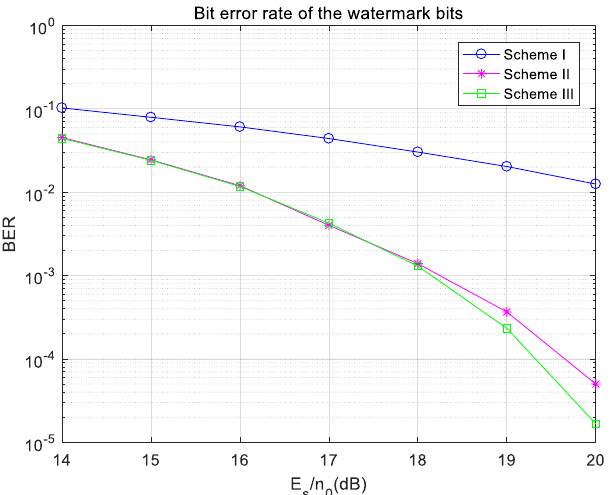
Figure 10. Bit error rate of the watermark bits under ideal synchronization in the Gaussian chan- nel.